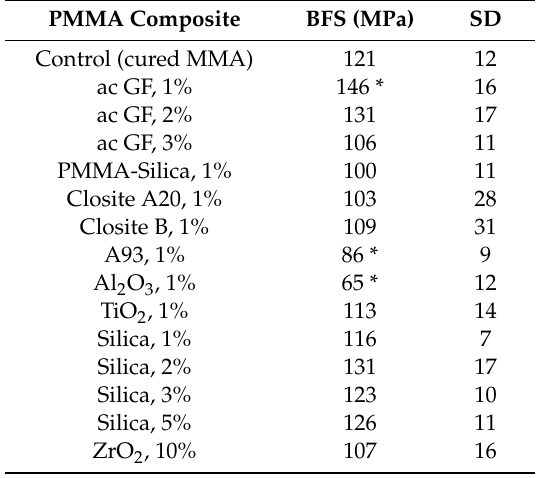
Table 1. Comparison of biaxial flexural strength of filler added resin and plain resin, MMA. * Statistically significant compared to the control